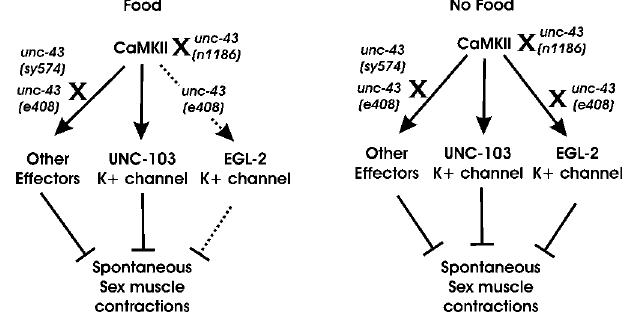
Figure 3. Genetic Interactions between CaMKII, EAG, and ERG-like K þ Channels in Well-Fed and Food-Deprived Conditions Arrows represent wild-type CaMKII acts upstream of the K þ channels and other muscle contraction regulators; bars show that spontaneous muscle seizures are suppressed. An ‘‘ X ’’ adjacent to an unc-43 allele name denotes which specific genetic pathway is compromised by the mutant allele. The dashed arrow and bar lines denotes that the interaction between CaMKII and EAG K þ channels is only seen in the unc-43(e408) mutant background.